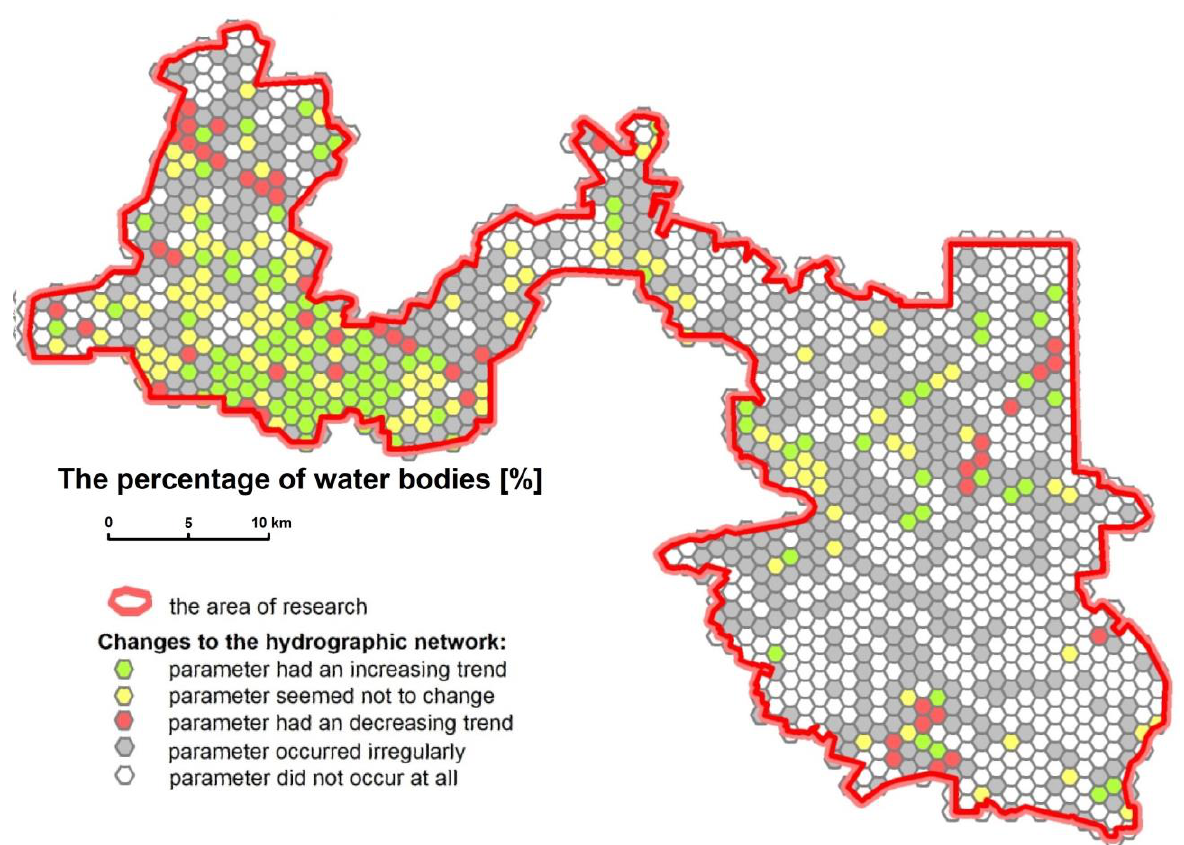
Fig. 8. Map of changes to the percentage of water bodies (own study based on the created